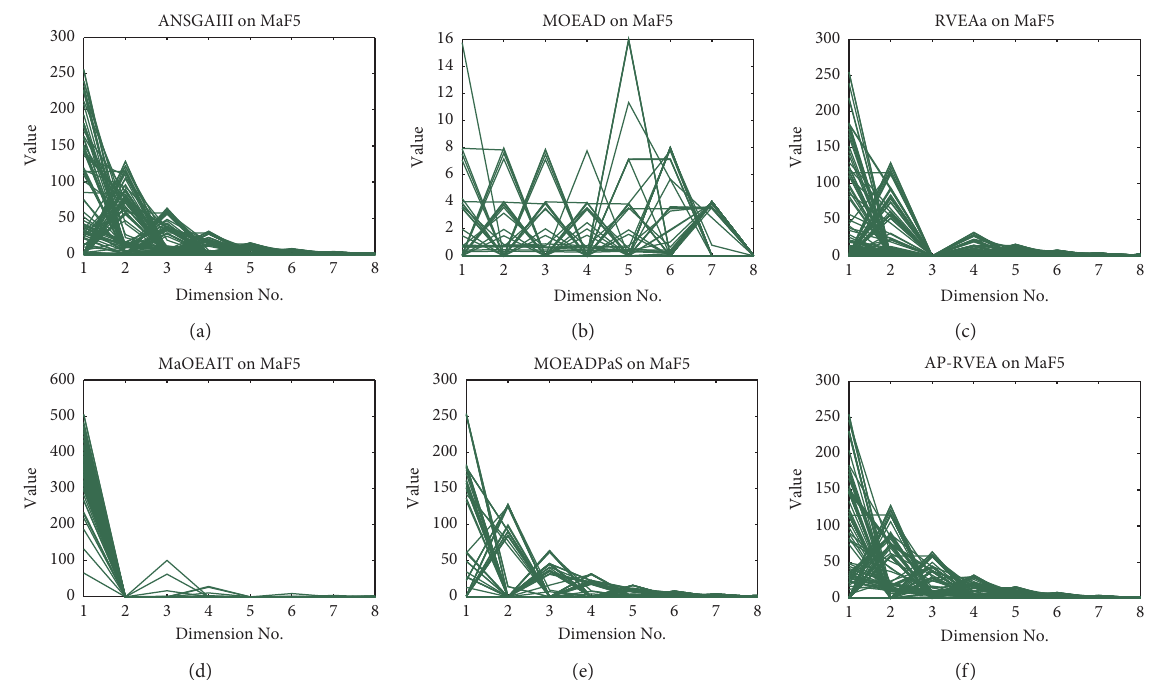
Figure 6: The best populations obtained by the six algorithms on 8-objective MaF5, shown by parallel